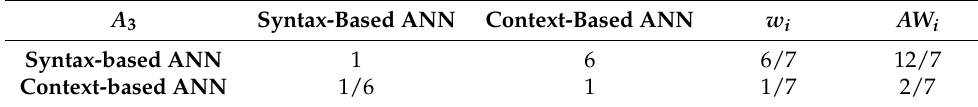
Table 6. The Proportion Of A 3 In The Strategies.